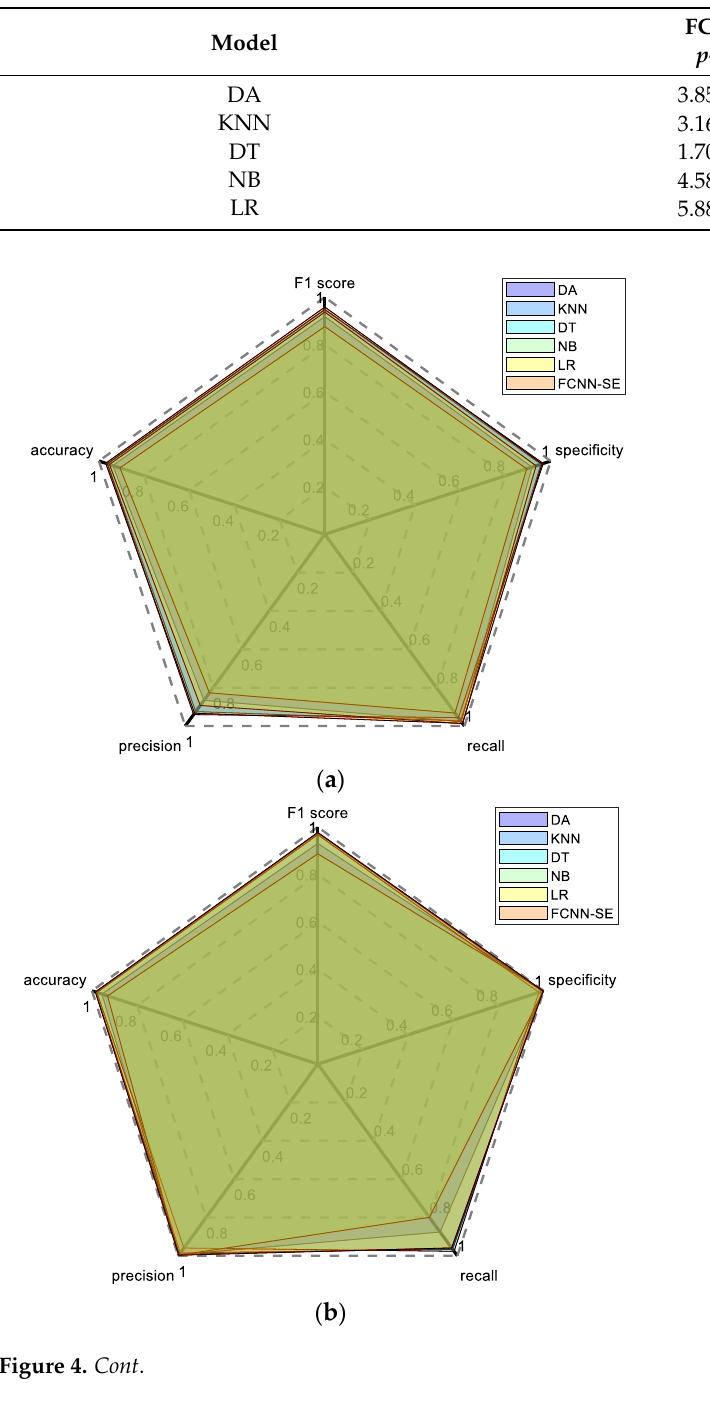
Table 2. The McNemar hypothesis test results.